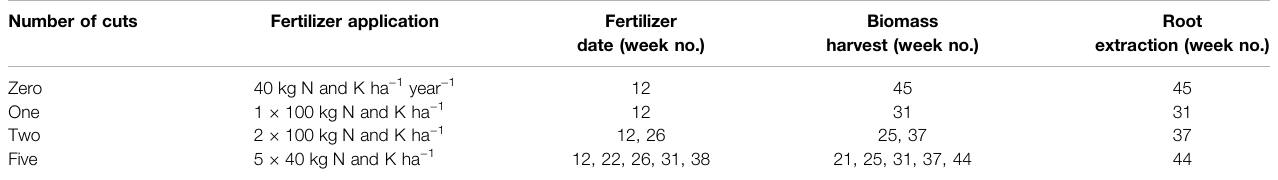
TABLE1| Datesandamountsoffertilizerapplication,calendarweeksofabovegroundbiomassharvestoccurrences,anddatesforrootextractionfollowingthe fi nalbiomass harvest for the various treatments as indicated by number of cuts. Number of